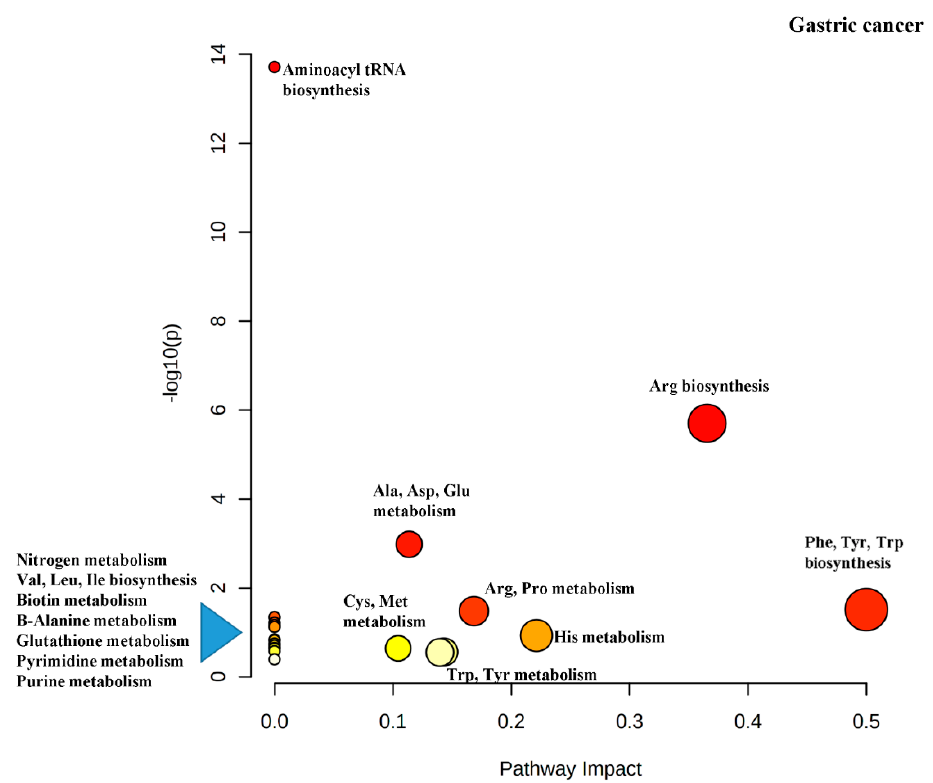
Figure 4. Pathway analysis performed using the altered metabolites from metabolomics data for gastric cancer. Each filled circle corresponds to a metabolic pathway. The x-coordinate (Pathway Impact) indicates the extent of pathway influence by the perturbed metabolites. The point size is related to the diversity of the pathway, based on the number of metabolites contained in the pathway. The ordinate represents the negative logarithm of the p -value obtained from the enrichment analysis done by the MetaboAnalyst software. The p -value (measure of pathway importance) is encoded in the color of the circles with red being the highest p -value.